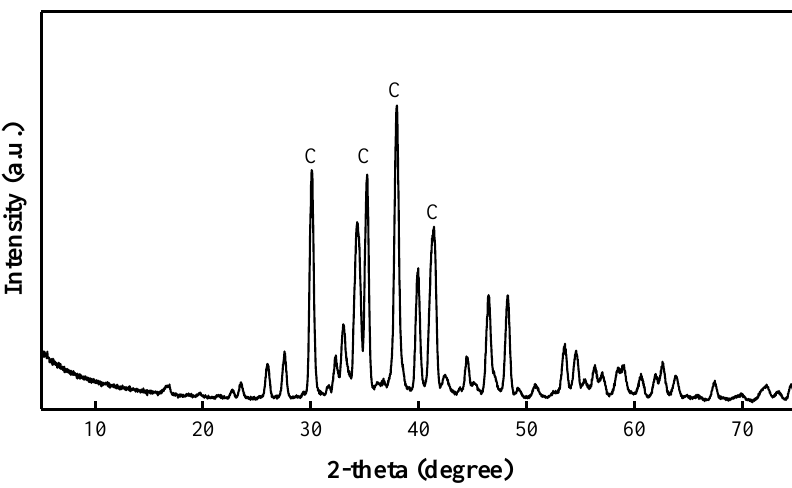
Figure 2. XRD pattern of Na 2 CO 3 (C: Na 2 CO 3 ).